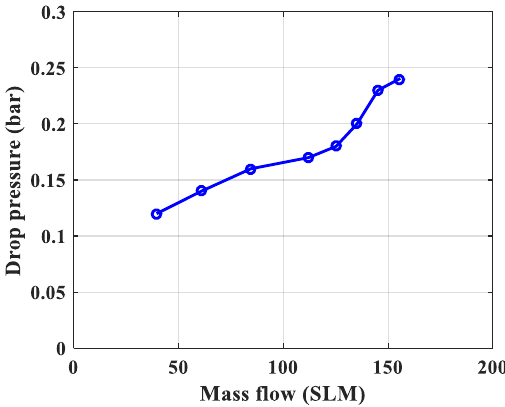
Figure 18. Drop pressure depends on incoming air flow input.